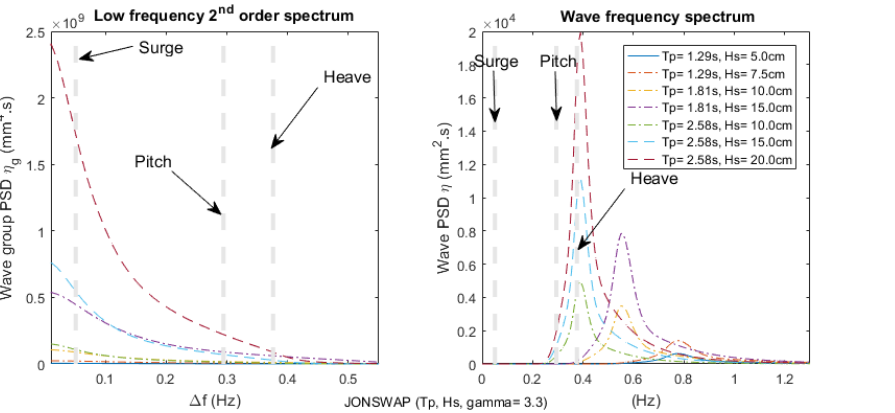
Figure 11. Theoretical JONSWAP wave spectra ( right ) and the associated wave group spectra ( left